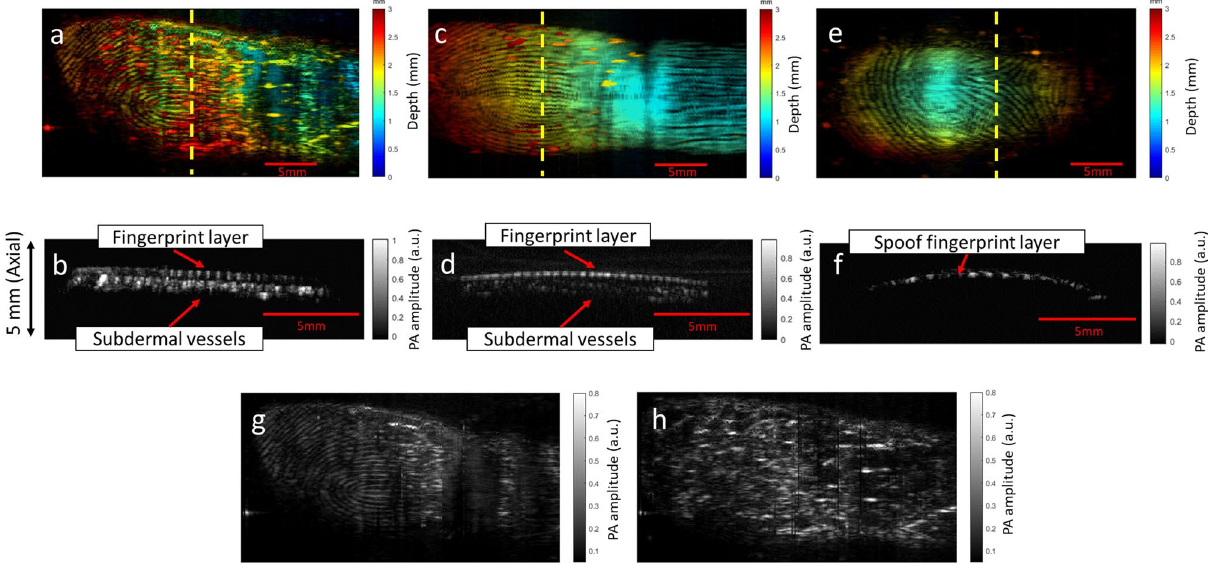
Figure 4. PAT results of human fingerprint. ( a ) Depth-encoded MAP image of the fingerprint obtained with ultrasound gel coupling. ( b ) Cross-sectional PAT image across the yellow dashed line in ( a ). ( c ) Depth-encoded MAP image of the fingerprint obtained without ultrasound gel coupling. ( d ) Cross-sectional PAT image across the yellow dashed line in ( c ). ( e ) Depth-encoded MAP image of the spoof fingerprint obtained with ultrasound gel coupling. ( f ) Cross-sectional PAT image across the yellow dashed line in ( e ). ( g ) Extracted fingerprint MAP image with ultrasound gel coupling. ( h ) Extracted subdermal vasculature MAP image with ultrasound gel coupling.